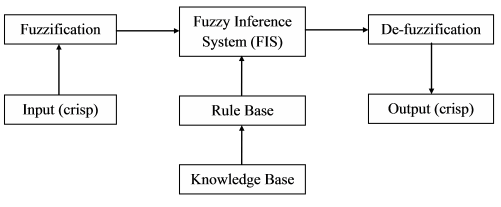
Fig. 3. Membership functions for input variables (C r ,C p and C m )